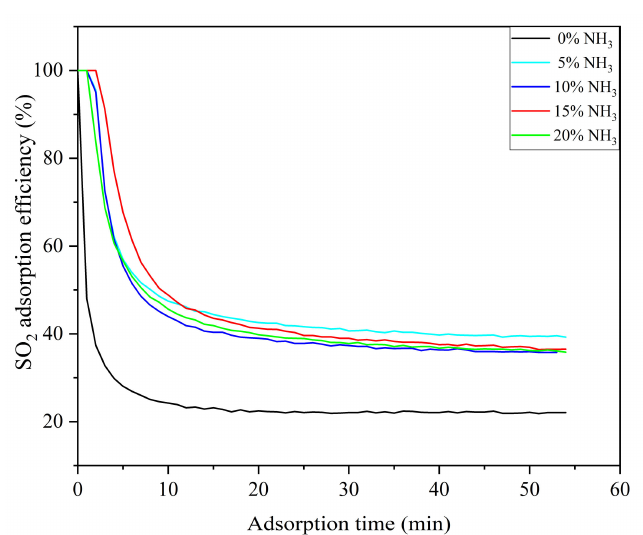
Figure 2. Effect of modified activated coke with different NH 3 concentrations on SO 2 adsorption